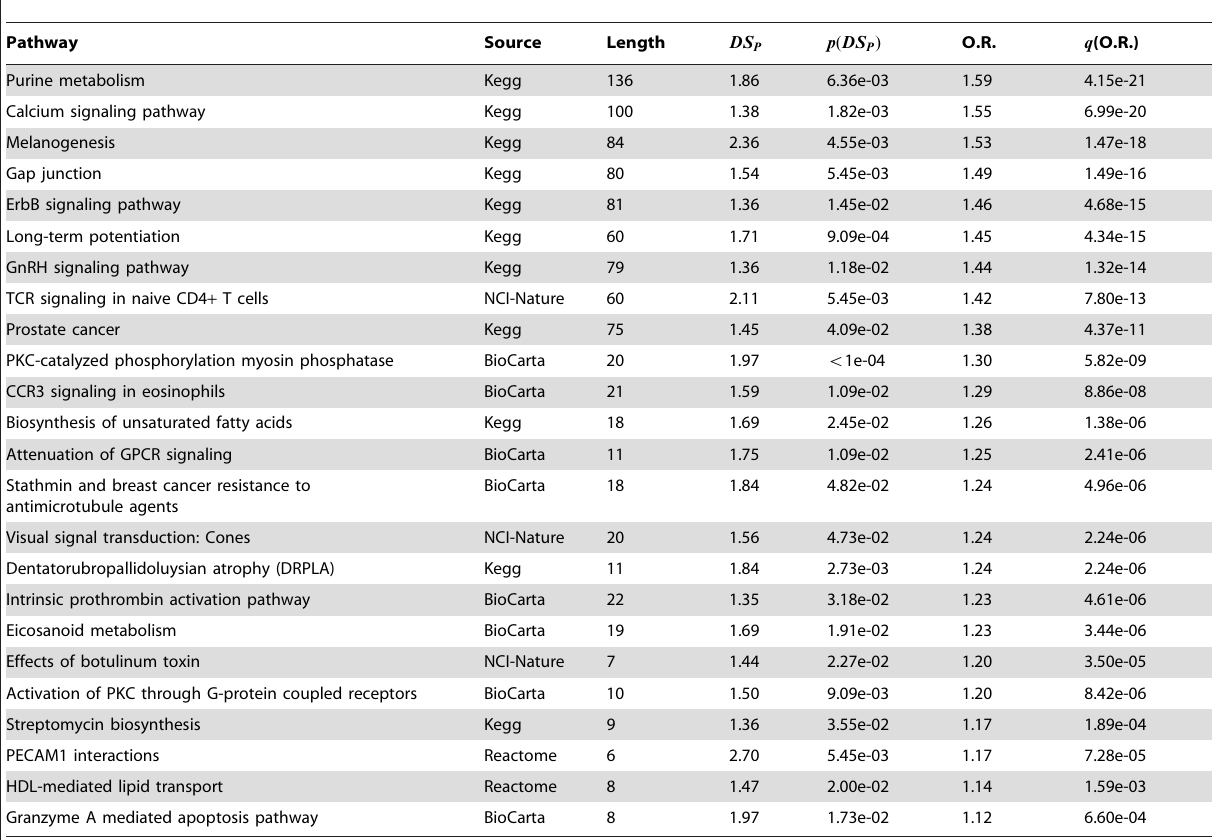
Table 2. PID pathways with significant DS P in the CGEMS breast cancer GWAS.